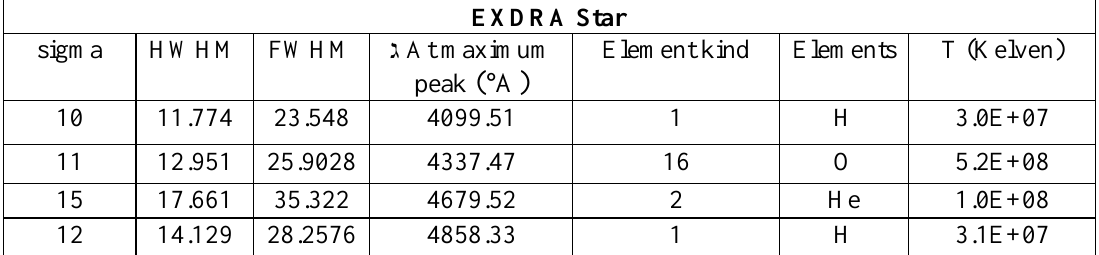
Fig.4: The Gaussian Fitting of SSUMI Star for the observed spectroscopic data. Table 1: Estimating parameters and computing temperatures in dwarf nova stars EXDRA.